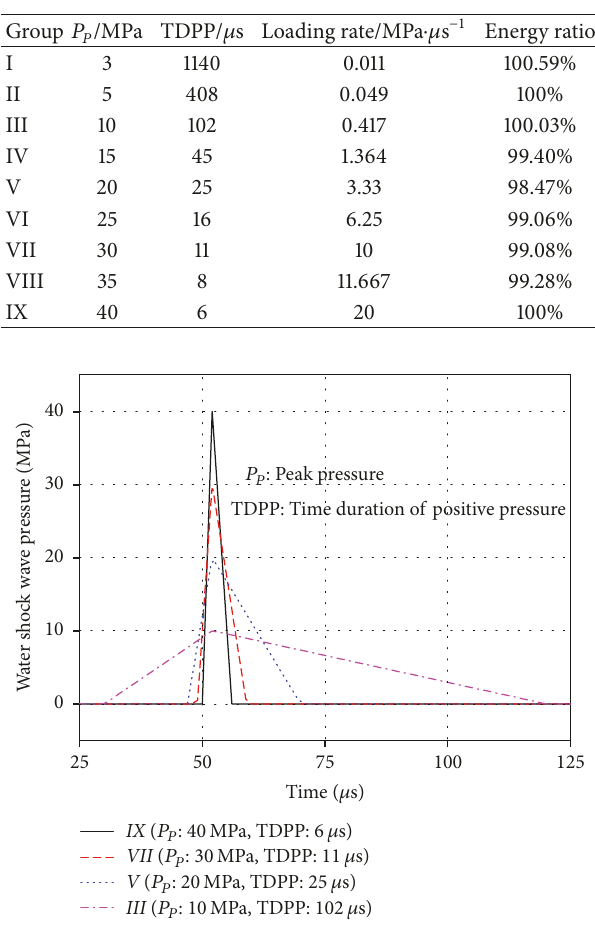
Table 3: Characteristics of nine groups HWSWs.